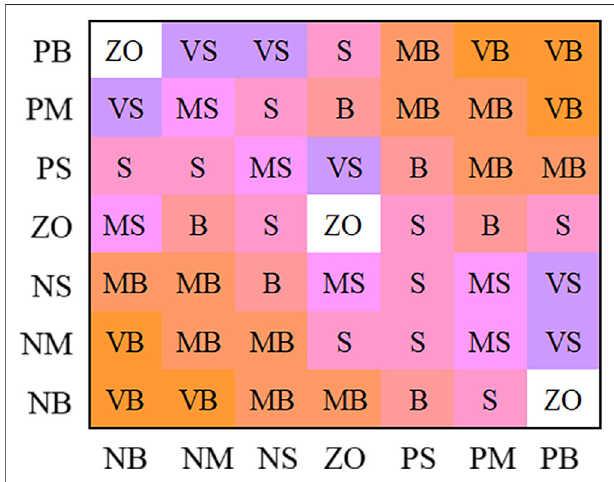
FIGURE 10 | Amendment rules of Δ K u .